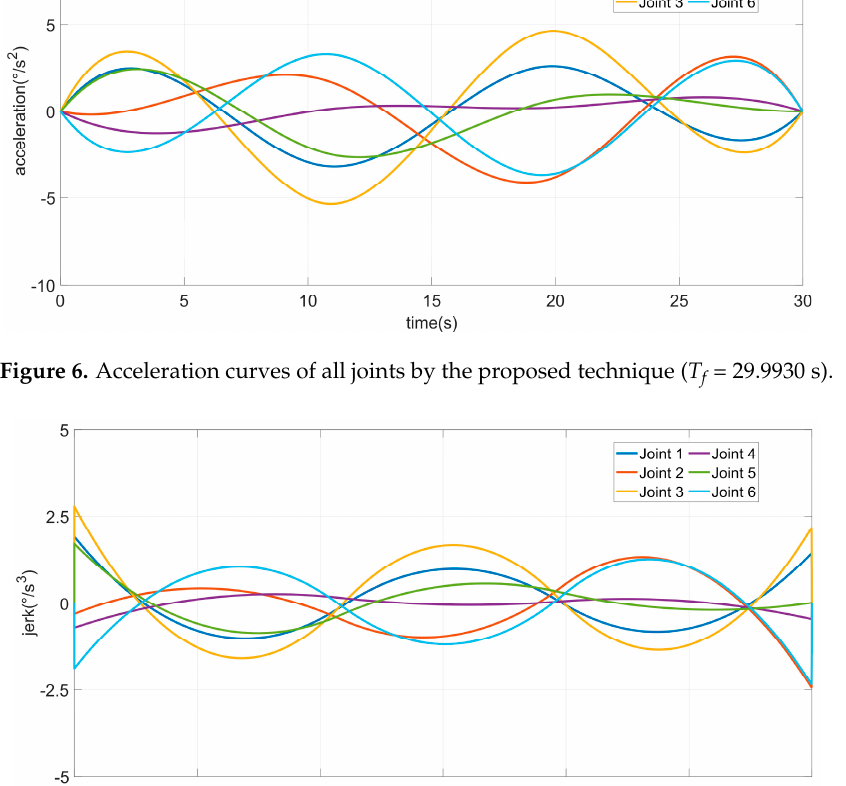
Figure 7. Jerk curves of all joints by the proposed technique ( T f = 29.9930 s).